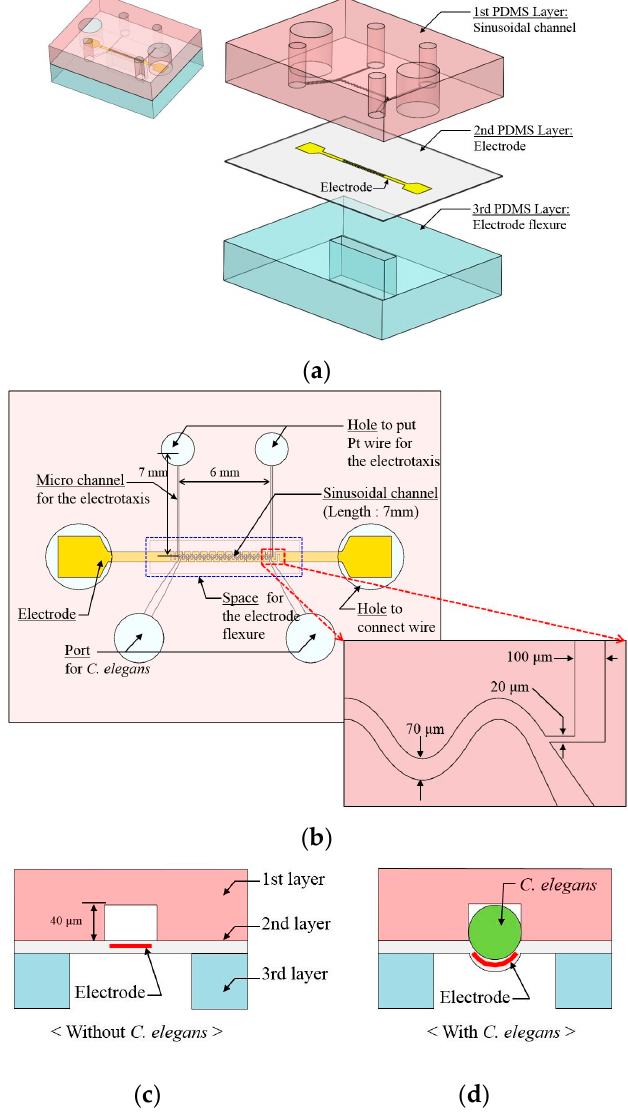
Figure 1. ( a ) Schematic diagrams of our proposed microfluidic device to measure the speed of C. elegans . It is composed of three polydimethylsiloxane (PDMS) layers and each PDMS layer had its own function. ( b ) Top view of our proposed microfluidic device to measure the speed of C. elegans . A micro channel for the electrotaxis is connected to a sinusoidal channel. The sinusoidal channel is on the electrode. ( c ) Cross sectional view of our prosed device. ( d ) When C. elegans is loaded into the sinusoidal channel, the worm can be introduced into the channel by the expansion of the second PDMS layer, which deforms the flexible electrode.